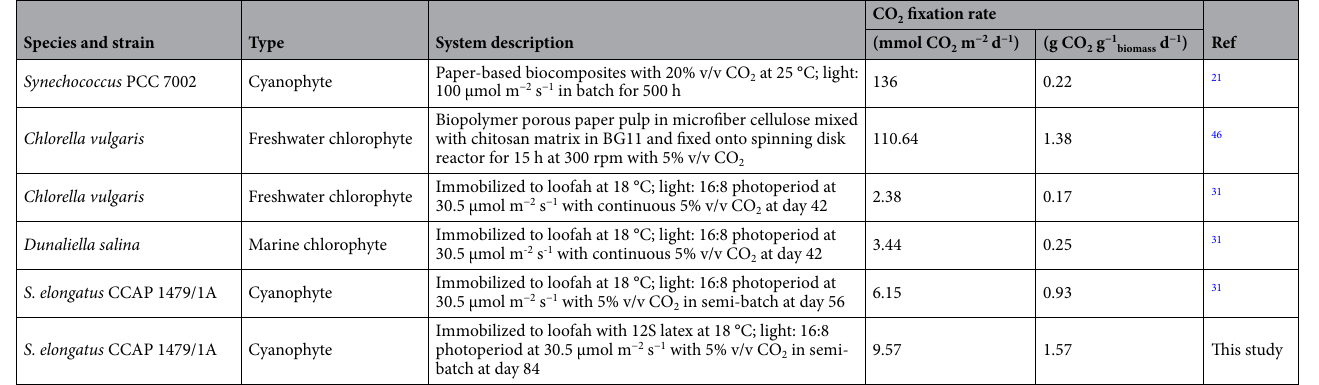
Table 1. Comparison of the highest CO 2 absorption rates with biocomposites relative to selected literature